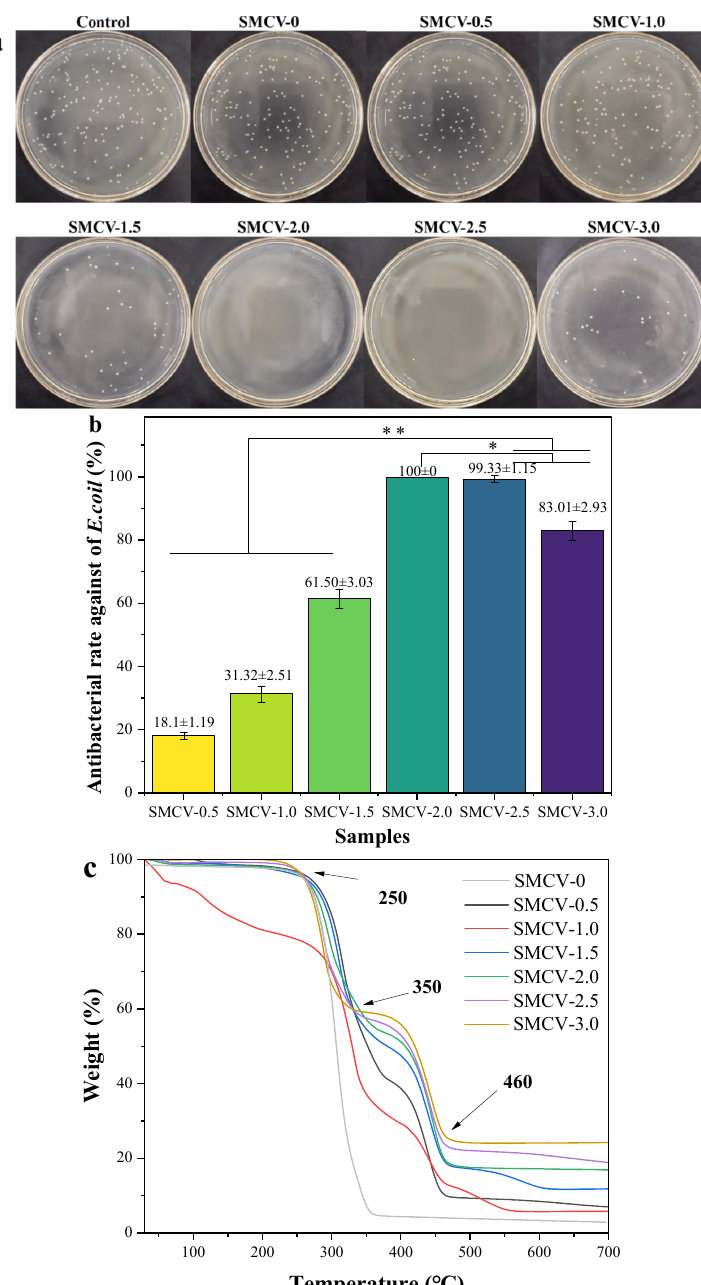
Figure 4. ( a ) The E. coli colony on LB solid medium (SMCV ‐ 0.5, SMCV ‐ 1.0, SMCV ‐ 1.5, SMCV ‐ 2.0, SMCV ‐ 2.5, and SMCV ‐ 3.0); ( b ) antibacterial rate of SMCV against E. coli , error bars represent mean ± SD for n = 3, * p < 0.05, ** p < 0.01; ( c ) TG curve of SMCV (SMCV ‐ 0, SMCV ‐ 0.5, SMCV ‐ 1.0, SMCV ‐ 1.5, SMCV ‐ 2.0, SMCV ‐ 2.5, and SMCV ‐ 3.0).